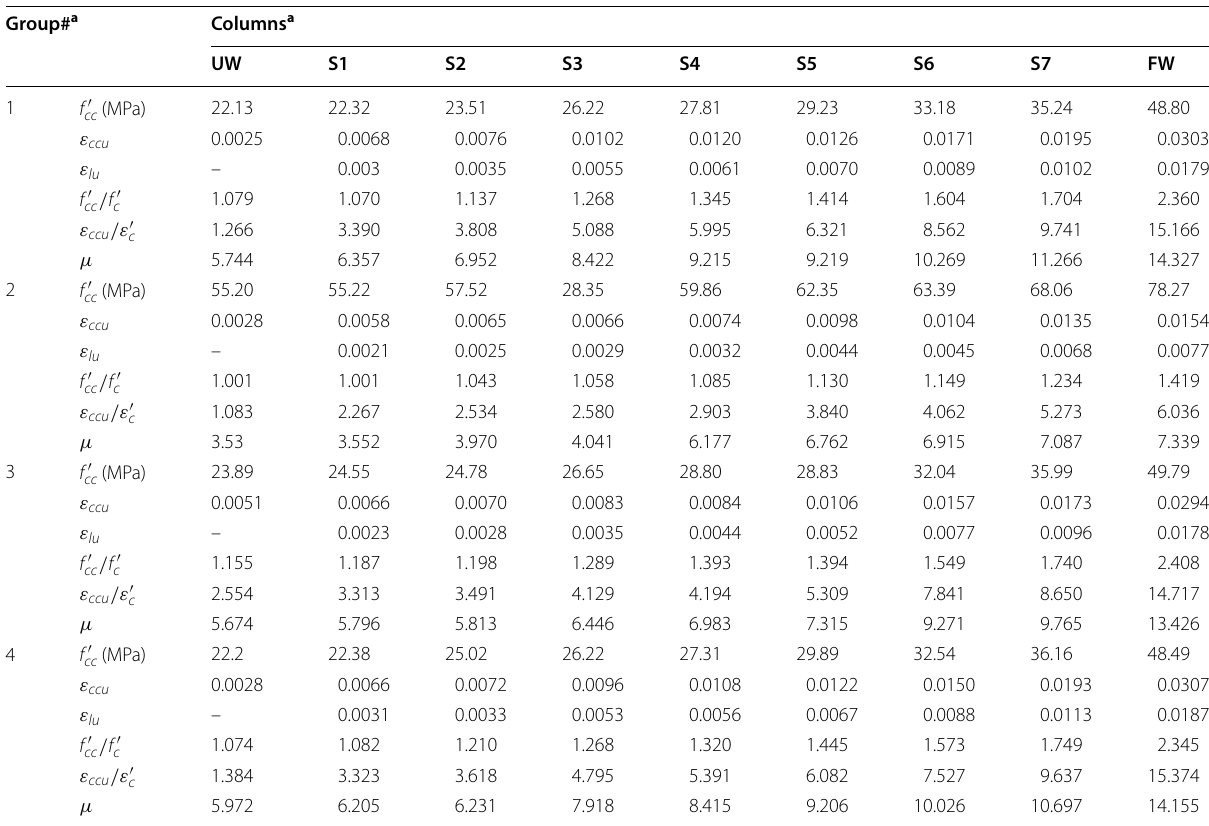
Table 3 Stresses, strains and ductility factors for the unwrapped columns (UW) and columns in Groups 1–4 (1 MPa 0.145 =